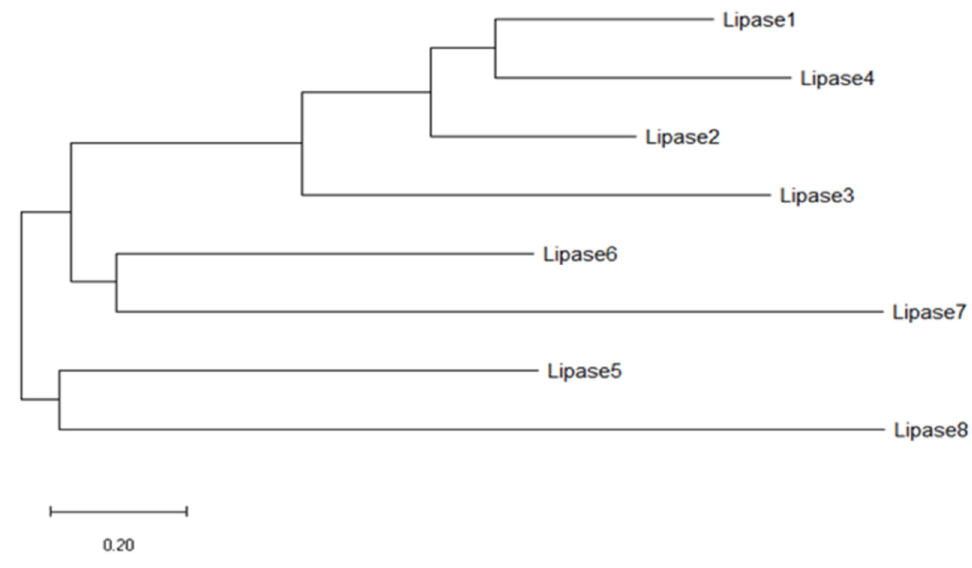
Figure 2. Dendrogram of lipase enzyme sequences.